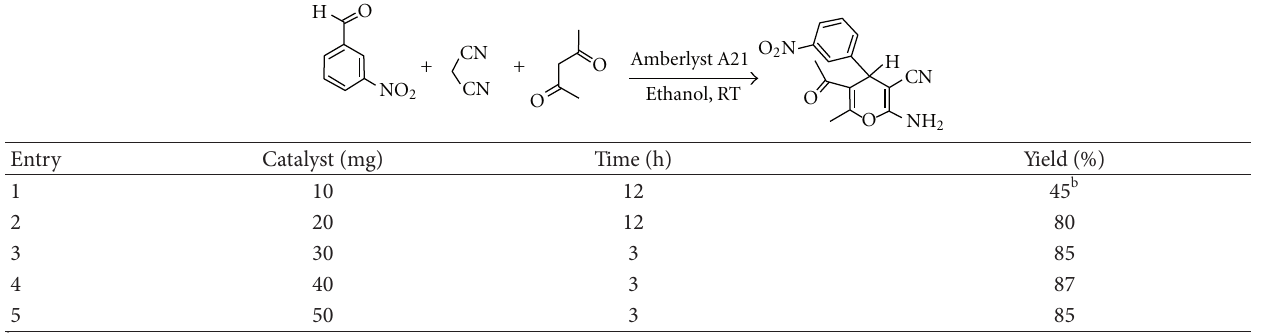
a Reaction conditions: stoichiometric ratio of all the reactants with base in ethanol at RT; b incomplete